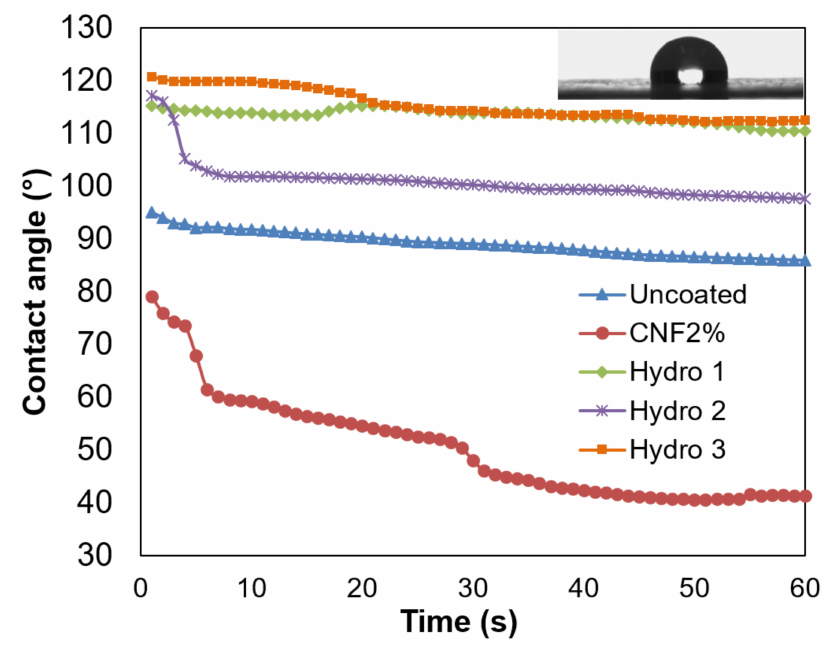
Figure 2. Dynamic contact angle of uncoated paper and sheets that were coated with formulations Hydro 1 – 3 , using the engraved applicator roll. The inset image corresponds to a water drop over a paper sheet coated with Hydro 3